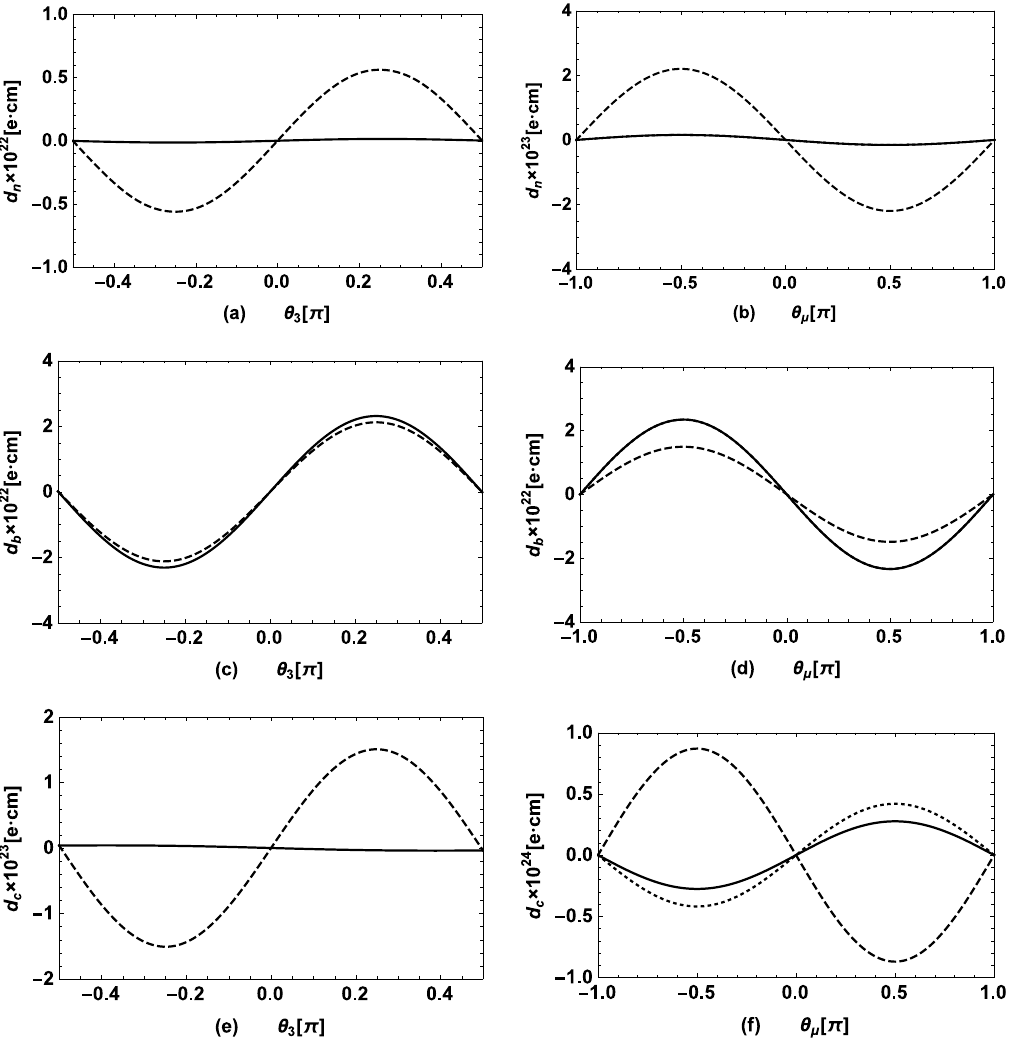
Figure 5 . d n , d b , d c versus (cid:18) 3 , (cid:18) (cid:22) are plotted, where the solid, dashed and dotted lines denote the one loop results, the sum of one-loop and two-loop gluino results, the sum of one-loop and two-loop Barr-Zee type results